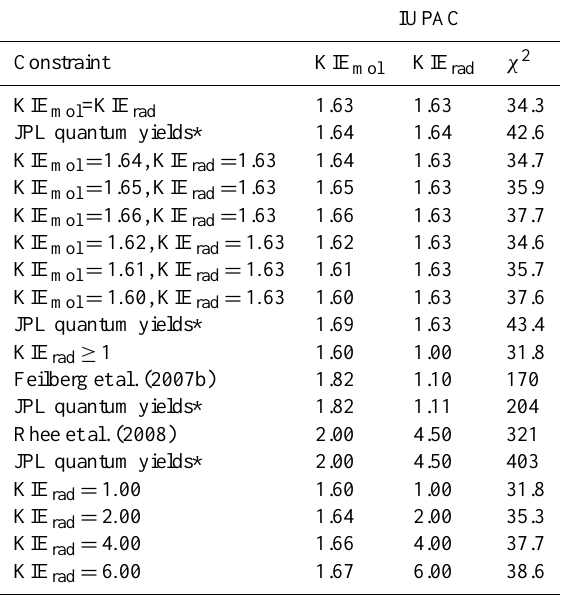
Table 2. χ 2 values for a range of KIE mol − KIE rad